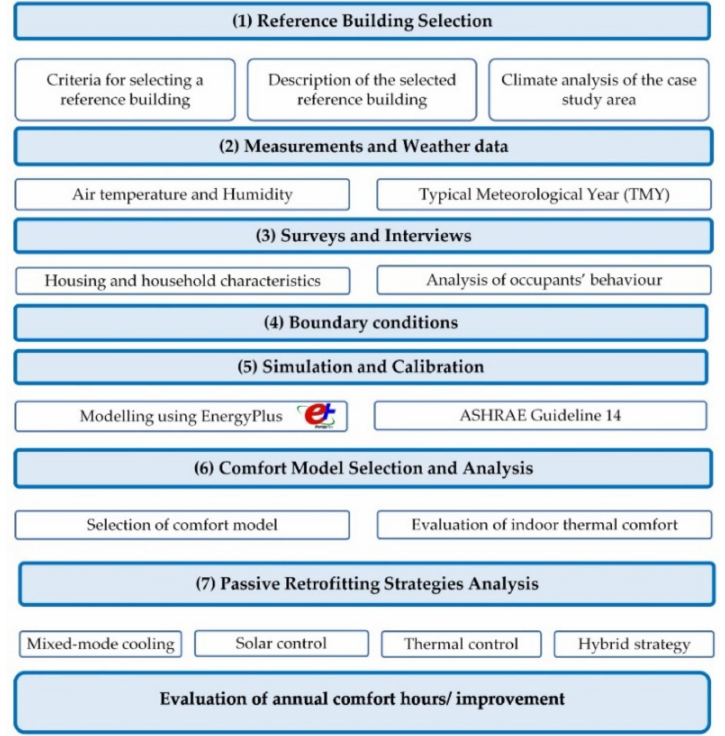
Figure 1. Conceptual study